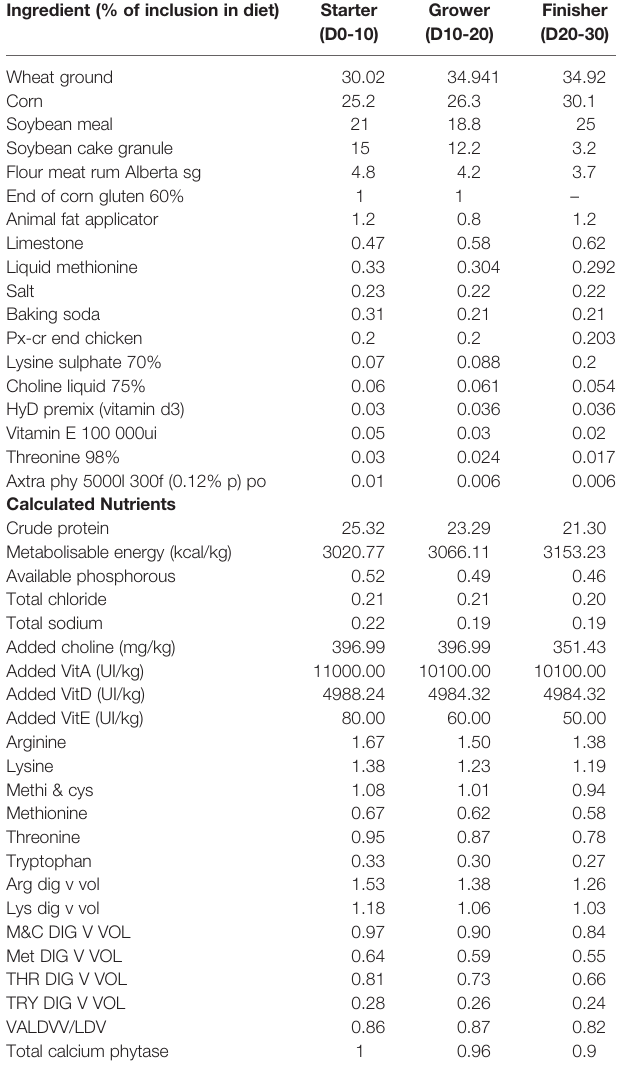
TABLE 1 | Composition of the diets used in this